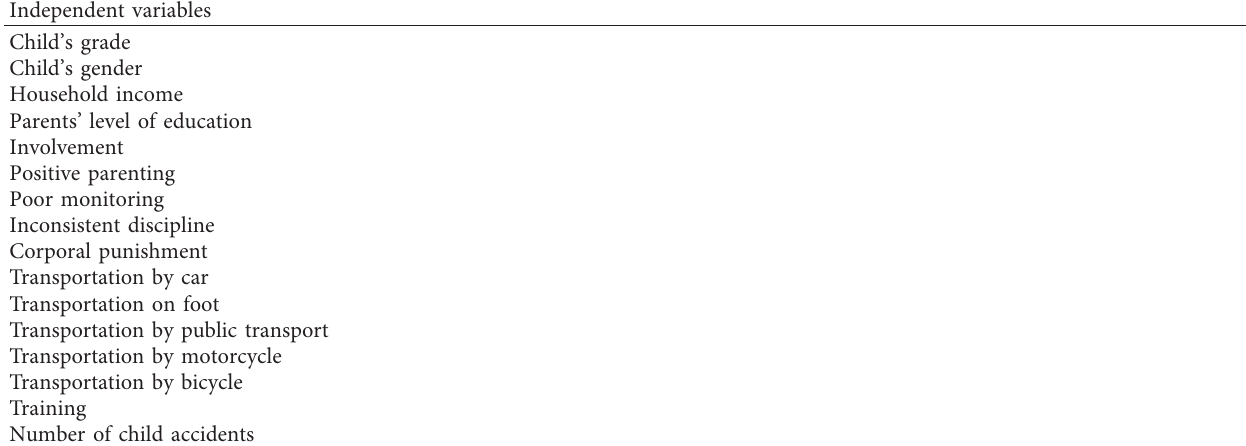
Table 5: Independent variables.